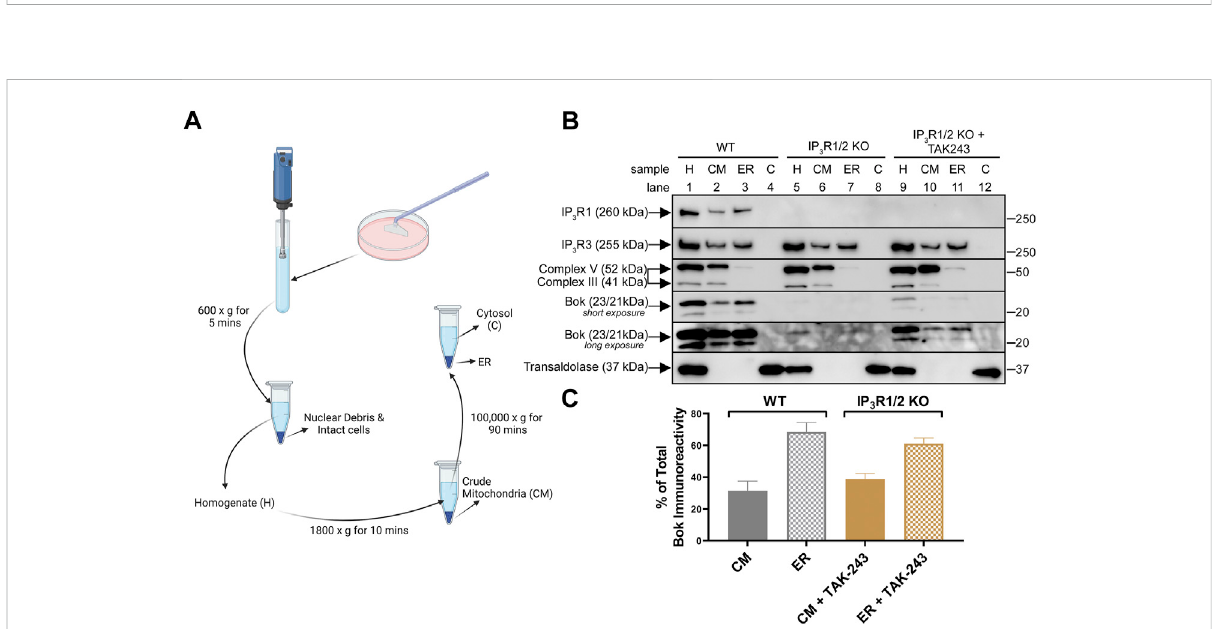
FIGURE 5 Subcellular localization of endogenous Bok. (A) , Summary of subcellular fractionation method created with BioRender.com. After cell disruption, centrifugation at 600 × g for 5 min produced a clear homogenate, H, free of nuclear debris and intact cells. Centrifugation of the H fraction at 1,800 × g for 10 min generated a crude mitochondria, CM, fraction (pellet) and a supernatant that was centrifuged at 100,000 × g for 90 mintogenerateER(pellet)andcytosol,C,(supernatant)fractions. (B) ,WTorIP 3 R1/2KOMEFs,incubatedwithoutorwith10 µMTAK-243for 1 h, weresubjectedto subcellular fractionation and samples were probed inimmunoblots as indicated. The fraction markers used were: complex V/ III for CM (inner mitochondrial membrane electron transport chain proteins), IP 3 R1 and IP 3 R3 for ER (multi-TM, ER-membrane located Ca 2+ channels), and transaldolase for C (cytosol-located pentose phosphate pathway enzyme). Note that 1) the CM fraction contains some ER, as both IP 3 R1andIP 3 R3werepresent(lane2),2)complexV/IIIwerenotpresentintheERandCfraction(lane3),indicatingthatthesefractionsdonotcontain mitochondria, and 3) transaldolase, was only detectable in the C fraction (lane 4), indicating that cytosol was absent in both the CM and ER fractions. (C) , Histogram showing quantitated Bok immunoreactivity in CM and ER fractions of WT MEFs and TAK-243-treated IP 3 R1/2 KO MEFs (mean ±